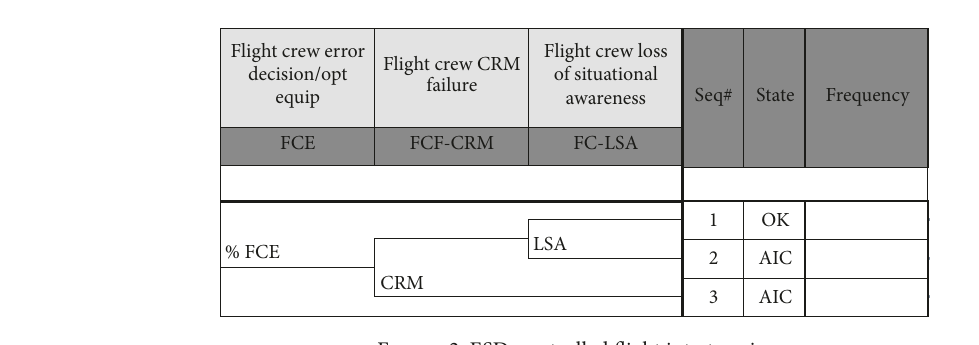
Figure 2: ESD-controlled flight into terrain.